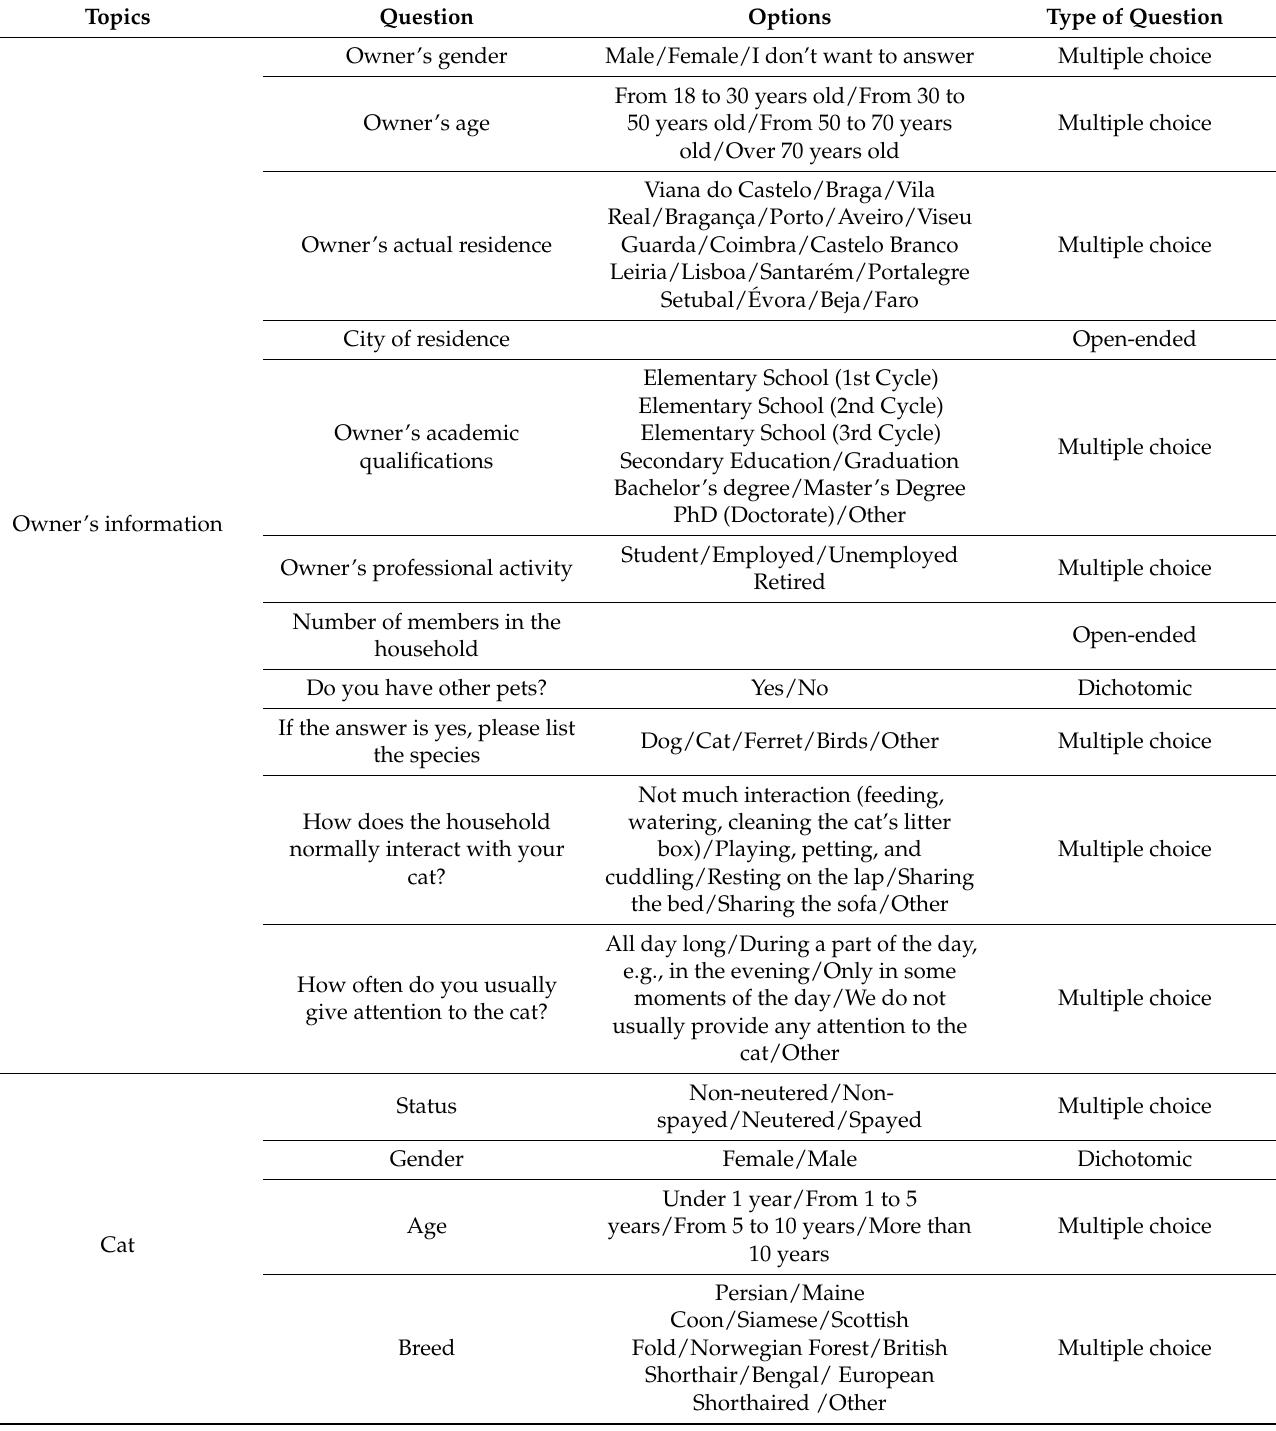
Table A1. Questionnaire applied to cat